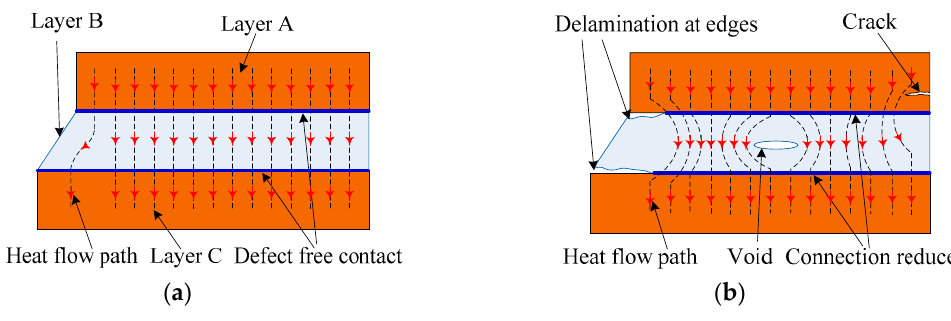
Figure 2. Joint characteristic degradation in multi-layer structure: ( a ) defect free connection; ( b ) rough surfaces with gradation defect.